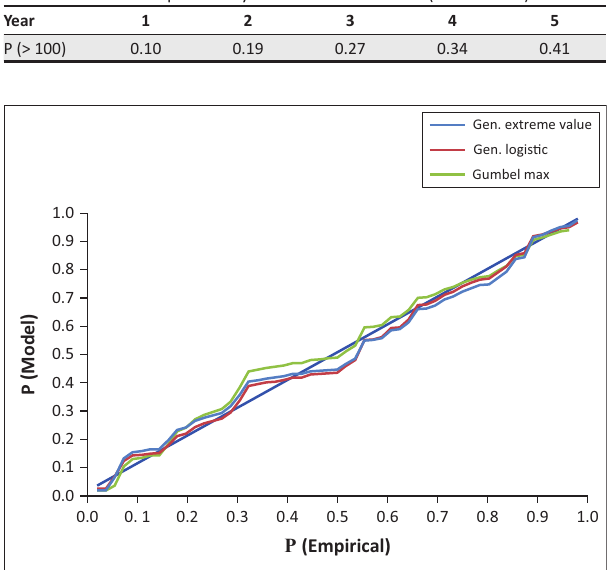
FIGURE 3: Probability–probability plot of annual maximum daily rainfall events for Nelspruit (1961–2015).